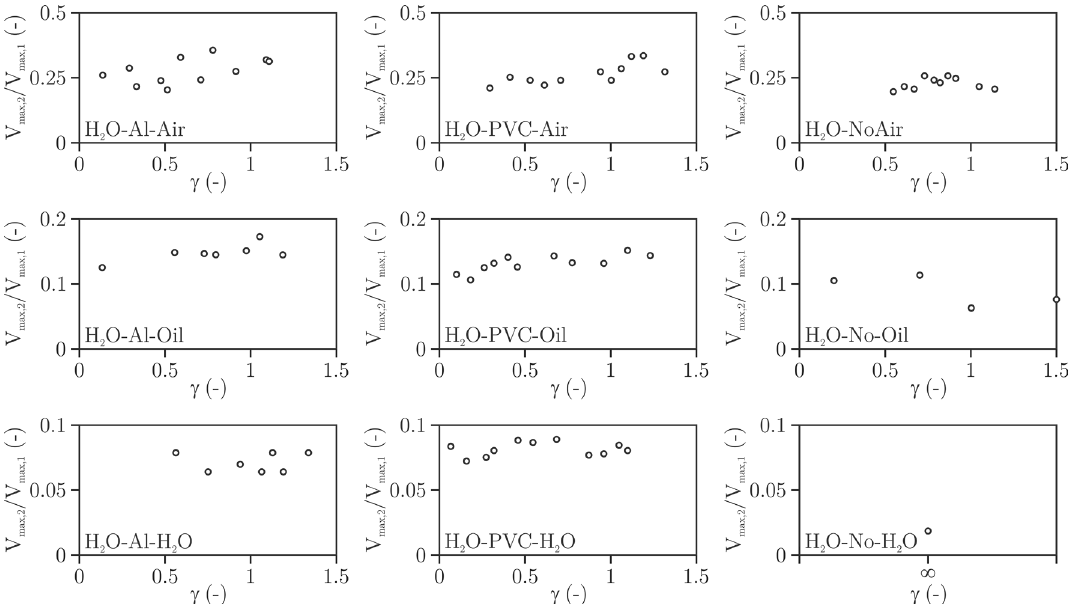
Figure 5. Cumulative volume of the rebounded bubble(s) nondimensionalized against the maximum volume of the bubble as a function of γ and the type of fluid-interface-fluid arrangement. Note different y scale for different